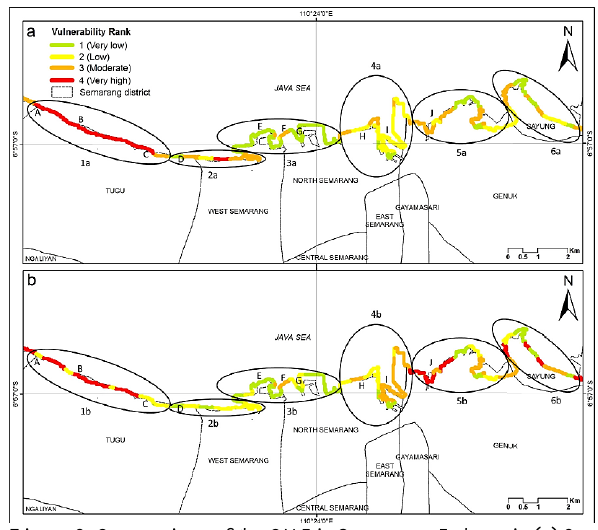
Figure 6. Comparison of the CVI in Semarang, Indonesia (a) 6- parameters CVI (b) 7-parameters CVI (Husnayaen et al .,